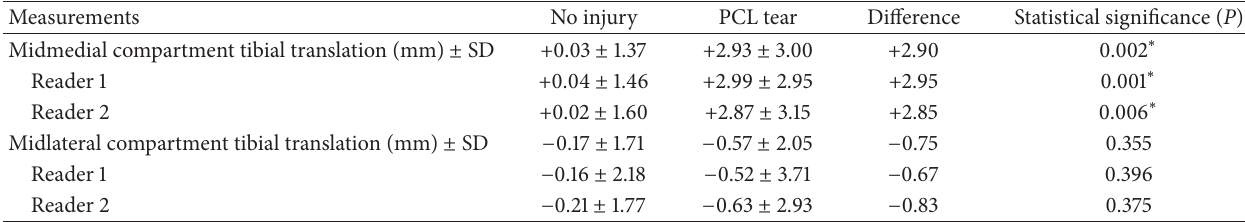
Table 3: Comparison of midmedial and midlateral compartment tibial translation measured on